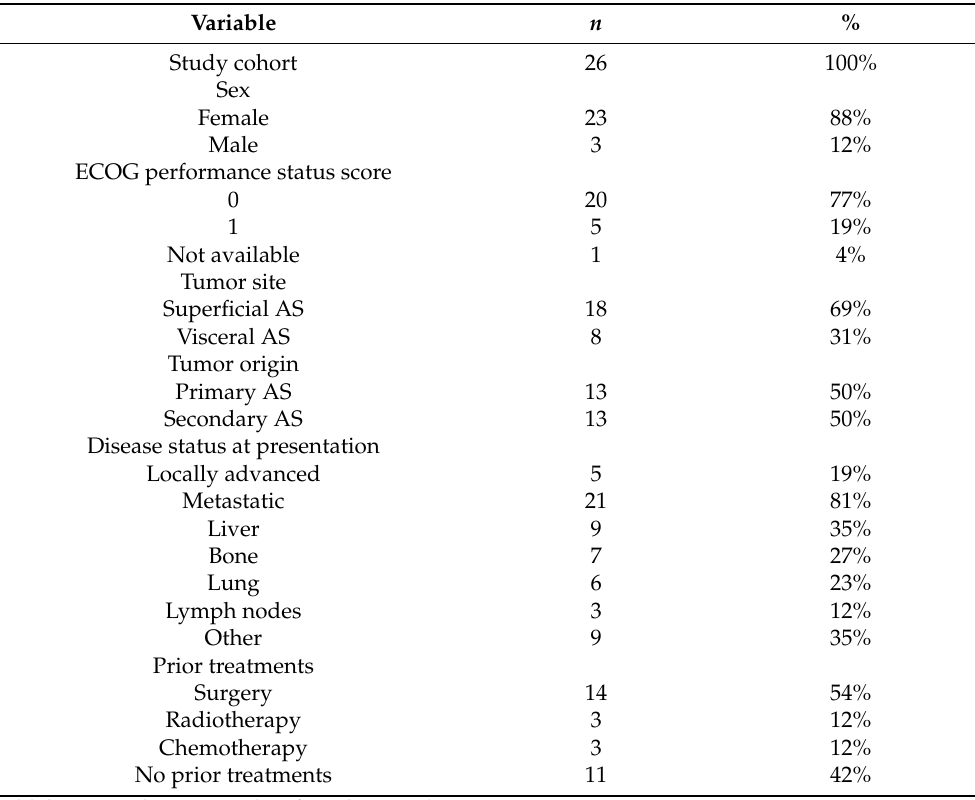
Table 1. Baseline demographics and disease